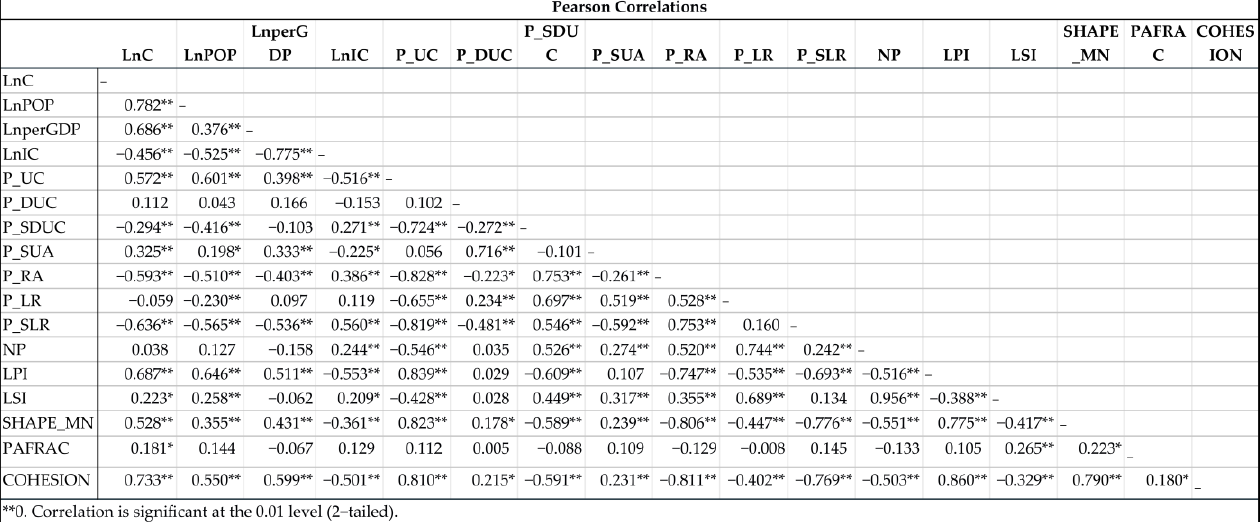
Figure A1. The Pearson correlation between variables.